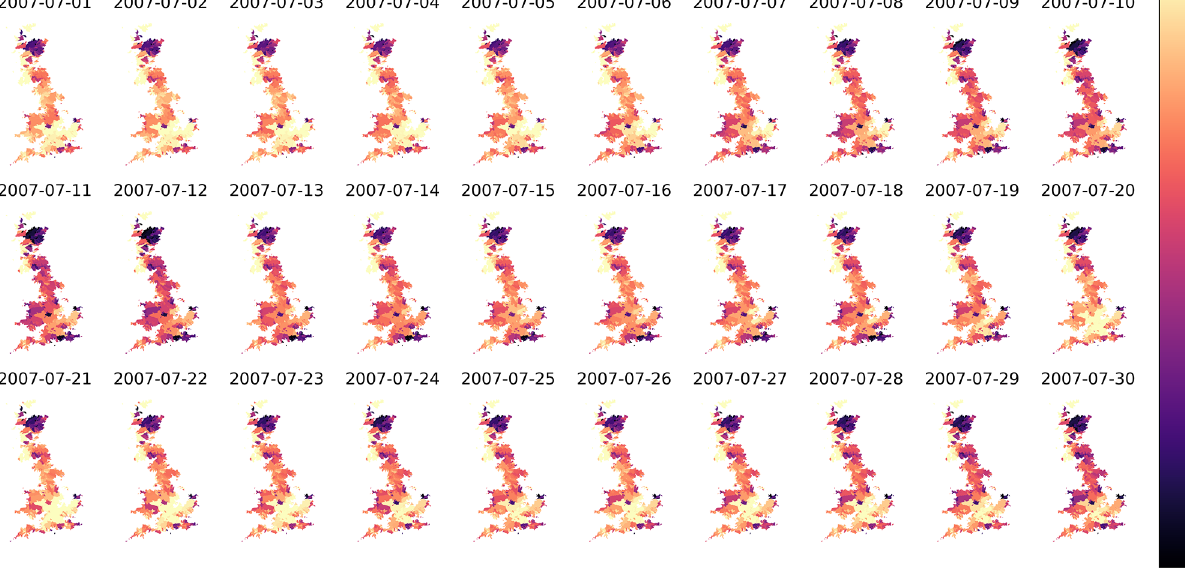
Figure 6. The lumped (catchment-averaged) soil moisture for 0–7cm at 30 daily timesteps covering most of July